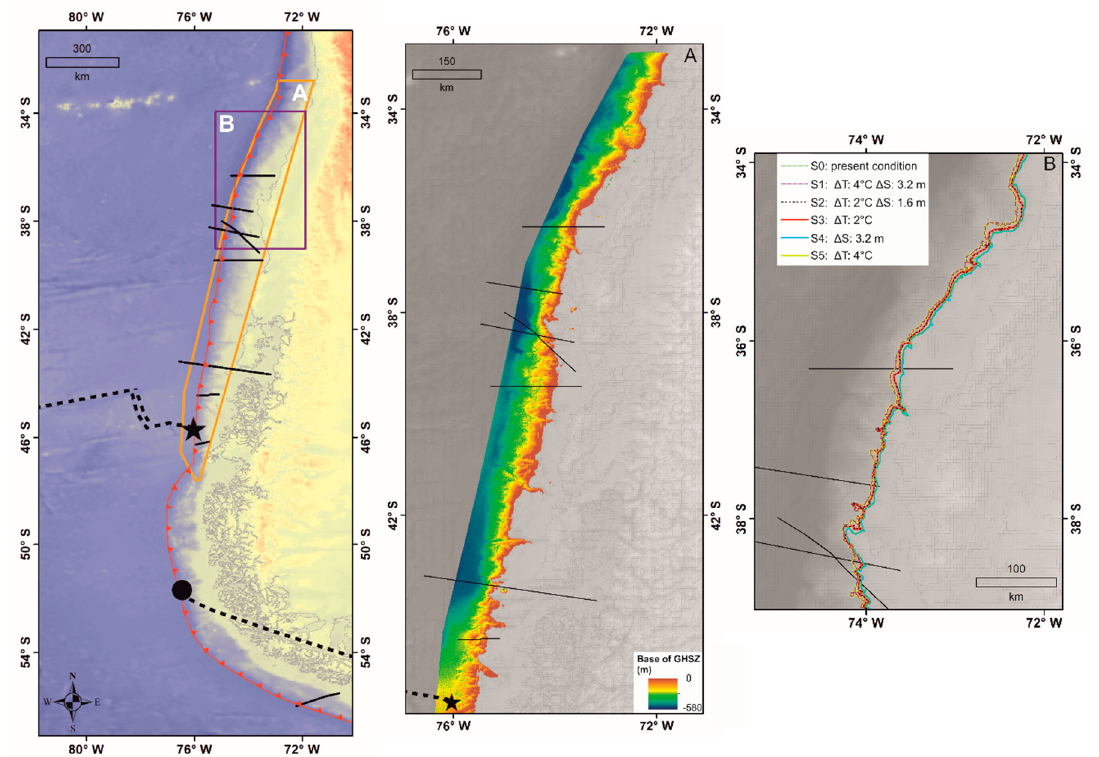
Figure 3. The left panel reports the area where modelling was performed by Reference [31]. Panel A shows the base of methane HSZ at the present conditions. In Panel B , the solid-colored lines represent the intersections between the base of the methane HSZ and the seafloor for scenarios reported in the legend and described in Reference [31].